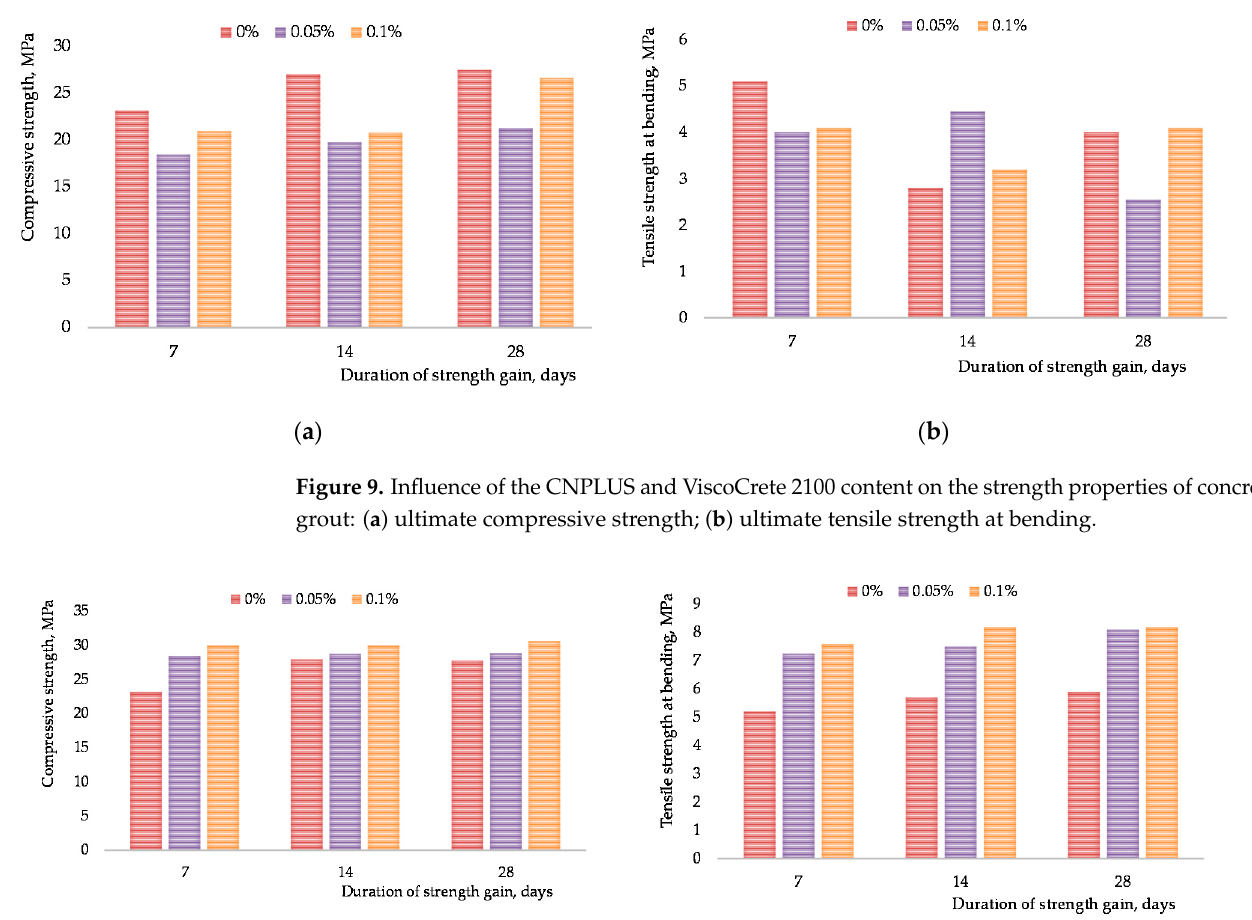
Figure 10 . Influence of the CNPLUS and Tensafor content on the strength characteristics of concrete grout: ( a ) ultimate compressive strength; ( b ) ultimate tensile strength at bending. grout: ( a ) ultimate compressive strength; ( b ) ultimate tensile strength at